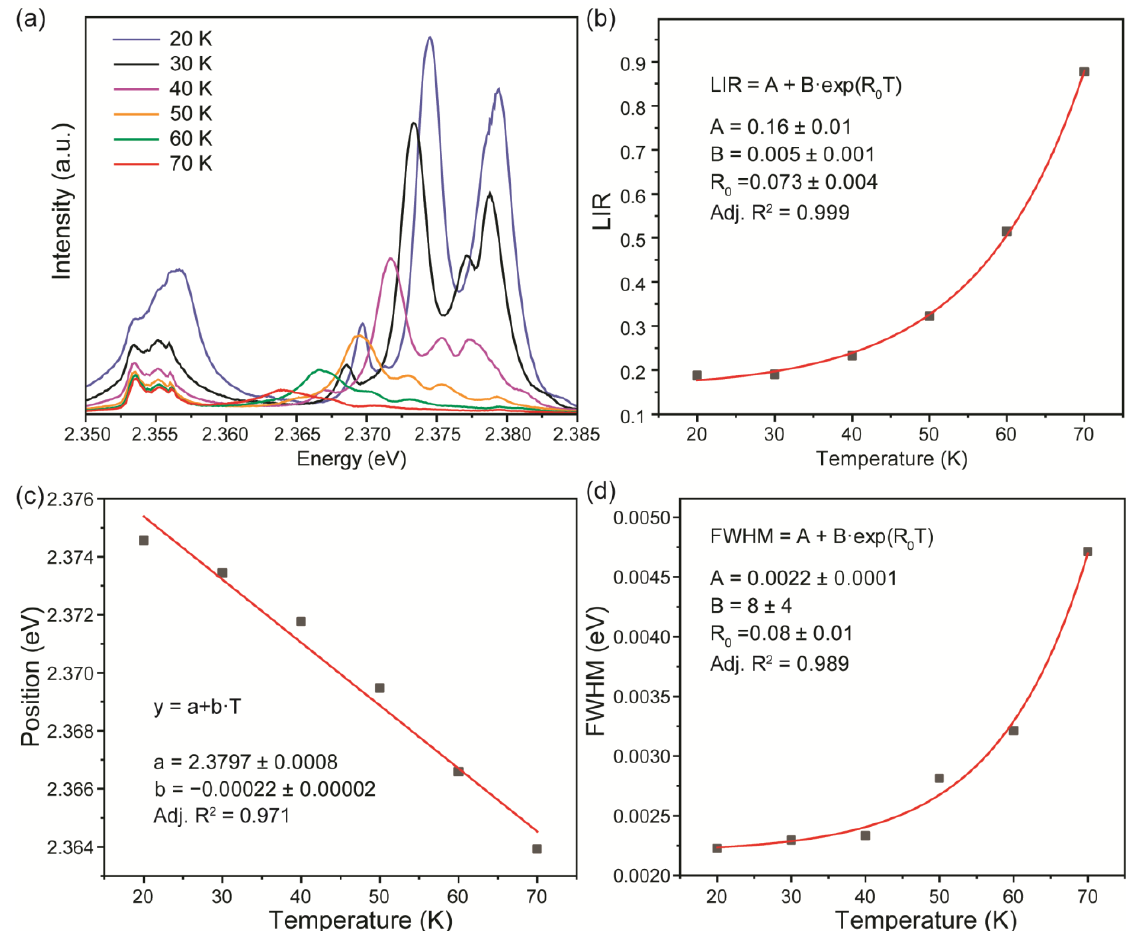
Figure 4. ( a ) Magnified area of ZnTe film emission spectrum; ( b ) LIR temperature dependence; temperature evolution of ( c ) 𝐷 𝑋0 spectral line position and ( d ) bandwidth of 𝐷 𝑋0 spectral line.